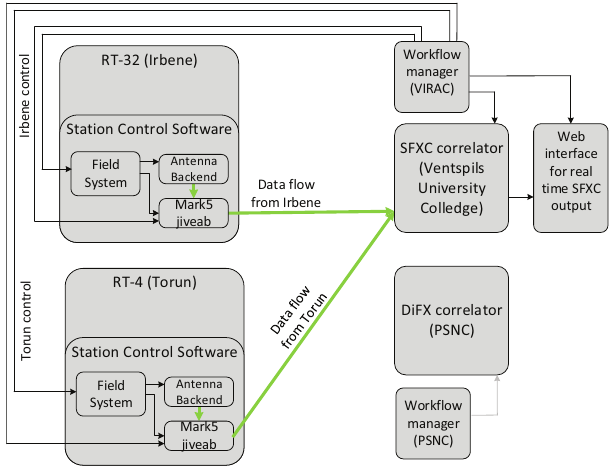
Fig. 6. An e-VLBI experiment. The data flow from the Torun RT-4 and the Ir- bene RT-32 radio telescopes has been processed in the VIRAC SFXC correlator. The experiment was managed by a VIRAC operator.